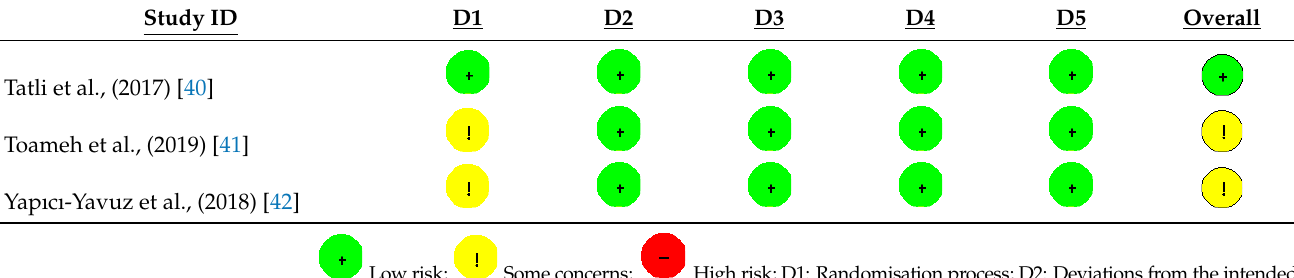
Table 2. Risk of bias assessment